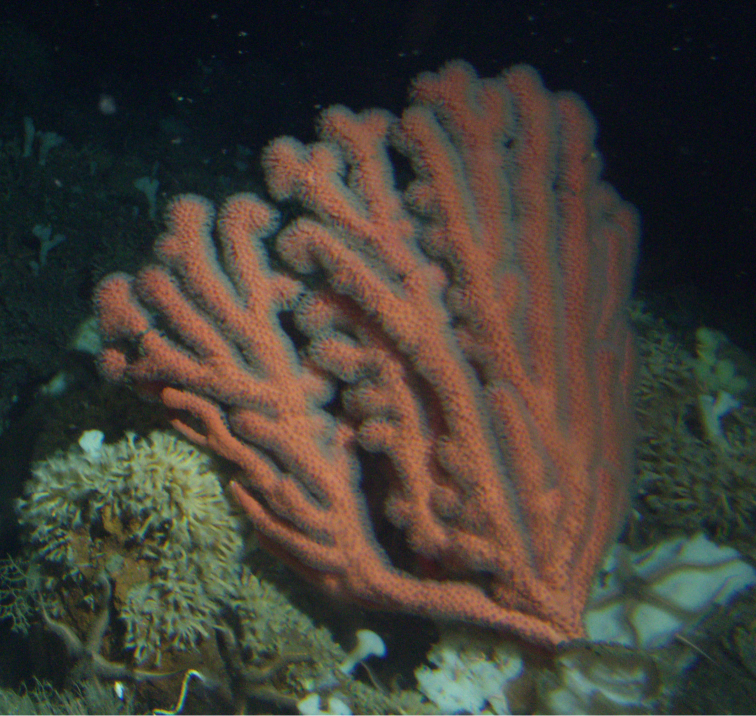
Placogorgia species A. In situ image, as seen in the Santa Barbara Channel. Image 6435B_Snook_018, taken by L. Snook. Image courtesy of Milton Love, UCSB.